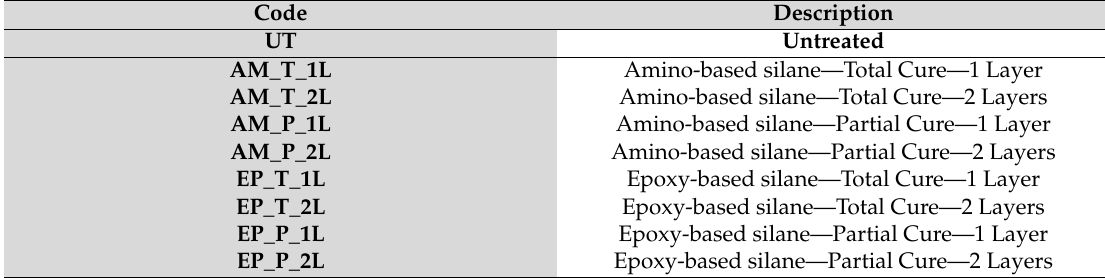
Table 5. Nomenclature and description of samples.